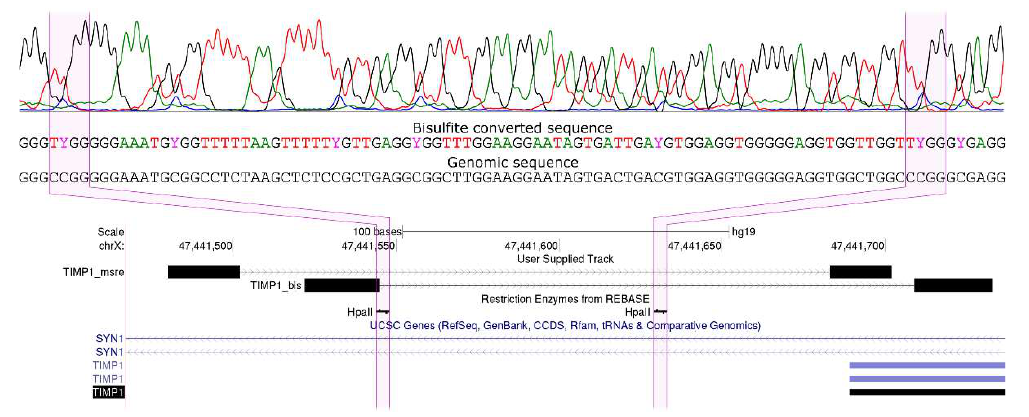
Figure 2. Bisulfite sequence of a fragment of the TIMP1 gene promoter region, validating partially methylated status of CpGs within the HpaII sites assessed by MSRE-PCR in this study. Blue peaks on the sequence correspond to methylated cytosines. HpaII sites are highlighted. TIMP1_msre, an MSRE-PCR product; primers are black rectangles and the insert is a tiny line. TIMP1_bis, a bisulfite PCR product; primers are black rectangles and the insert is a tiny line.